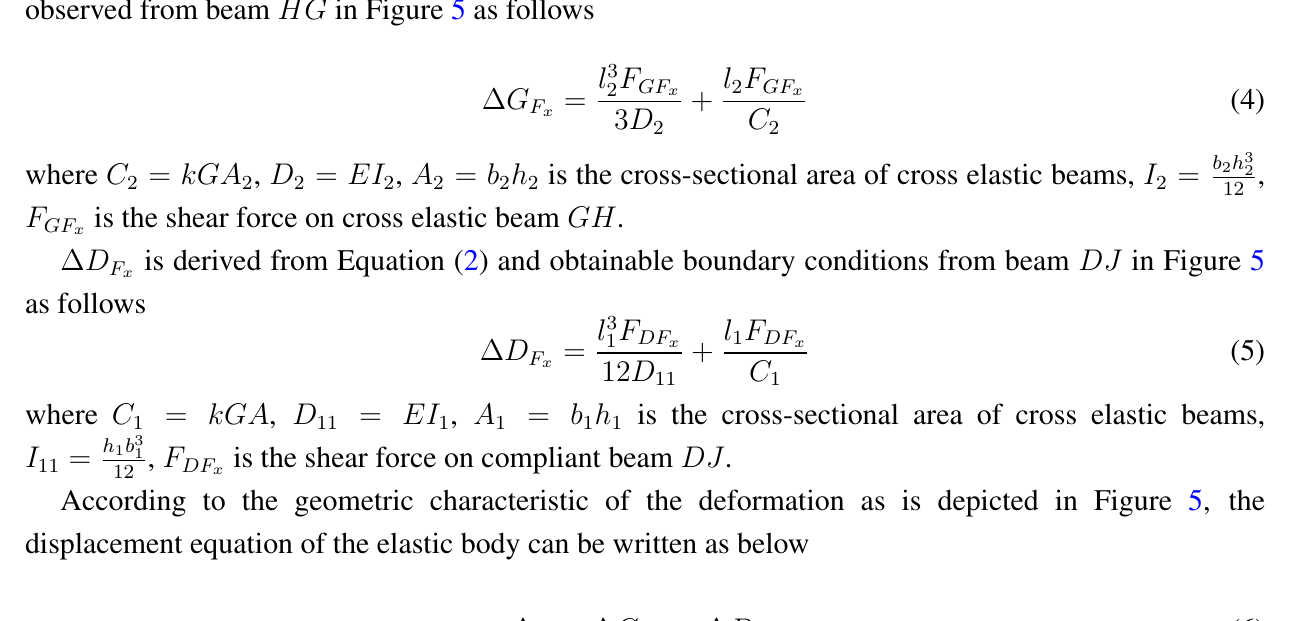
Figure 5. Mechanical model of an elastic body under F